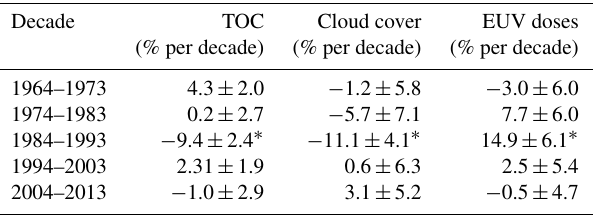
Table 4. Linear trends and standard error of annual means of TOC, cloud cover and EUV radiation doses for the individual decades of the period 1964–2013 at the Hradec Králové observatory; asterisks mark statistically significant trends ( α = 0.05).